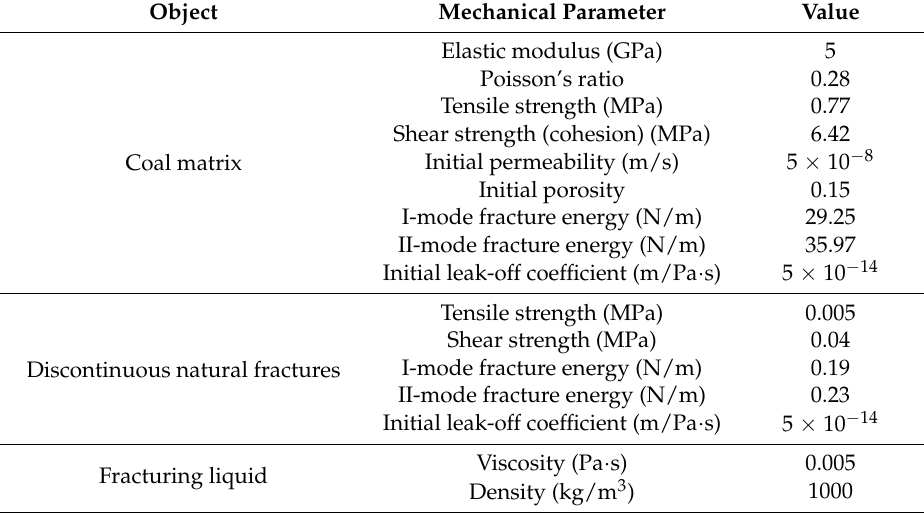
Table 1. The mechanical properties of the discontinuous fractures, coal matrix and fracturing liquid.